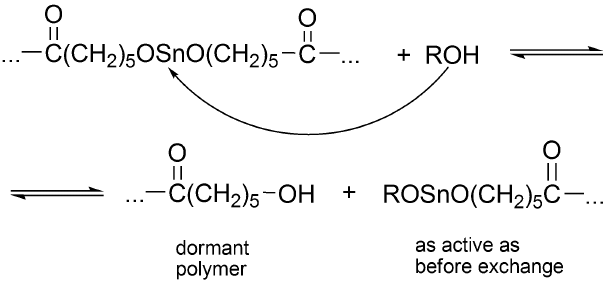
Scheme 12. Chain transfer and creation of dormant species in the polymerization of ε -caprolactone with the Sn(Oct) 2 /ROH